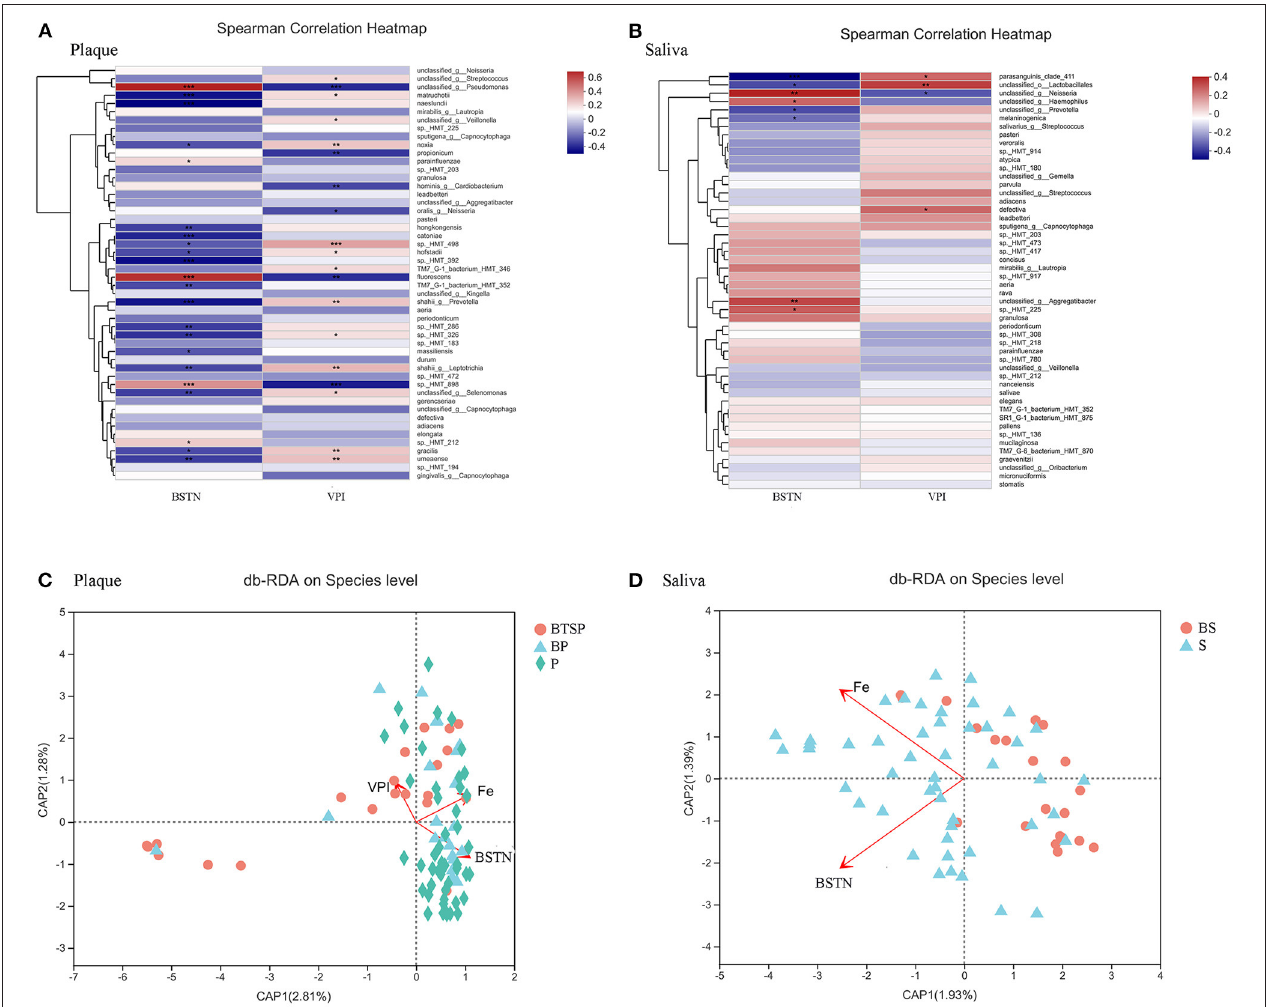
FIGURE 3 | Factors related to the bacterial community structure. BSTN: black-stained teeth number; VPI: visible plaque index; Fe: iron supplementation period; * P < 0.05, ** P < 0.01, *** P < 0.001. (A) Spearman’s correlation analyses for relative abundance (%) of the 50 most abundant species and related environmental factors in plaque samples. (B) Spearman’s correlation analyses of saliva samples. (C) db-RDA plot at the species level in plaque samples. (D) db-RDA plot of saliva